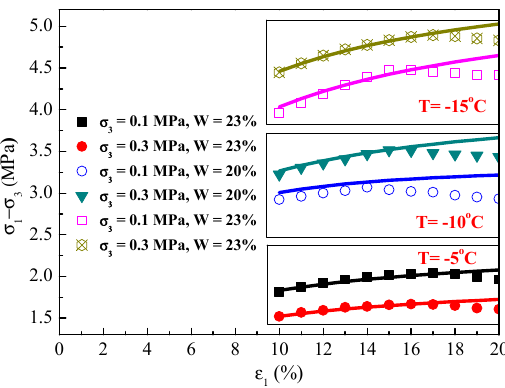
Figure 8. Inset of stress–strain curves between experimental (symbols) and predicted (lines) results of the MDC model.